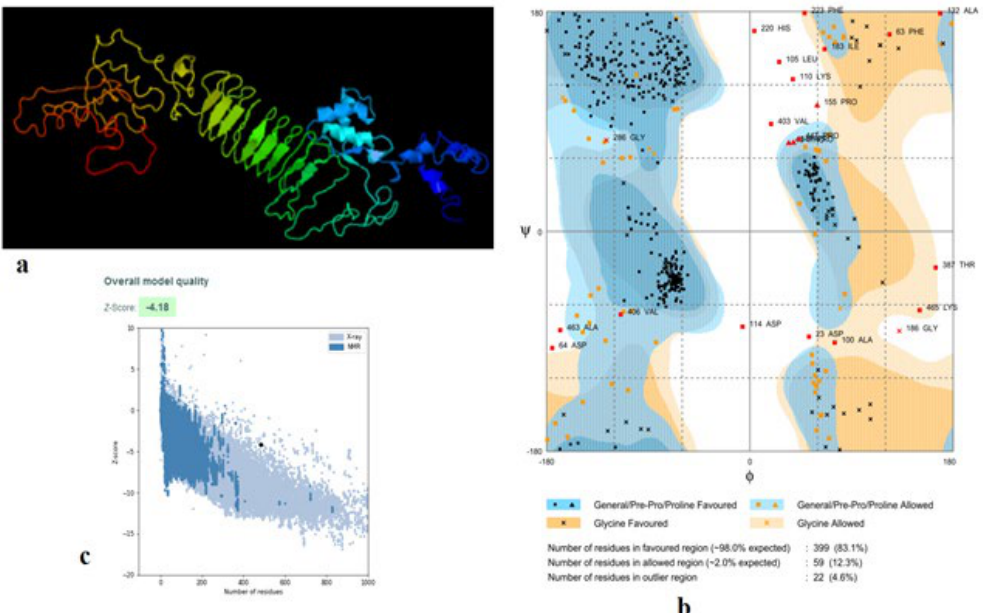
Fig. 5. (a) The 3D structure of the chimeric vaccine obtained by PHYRE2 server. (b) The 3D model after refinement in Galaxyrefiner server was validated by Ramachandran plot analysis that demonstrated 83.1%, 12.3% and 4.6% of protein residues in favoured, allowed, and disallowed (outlier) regions respectively. (c) ProSA server Z score was